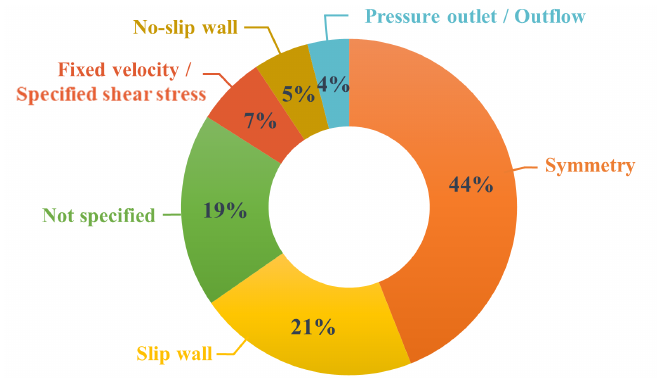
Figure 19. Top boundary